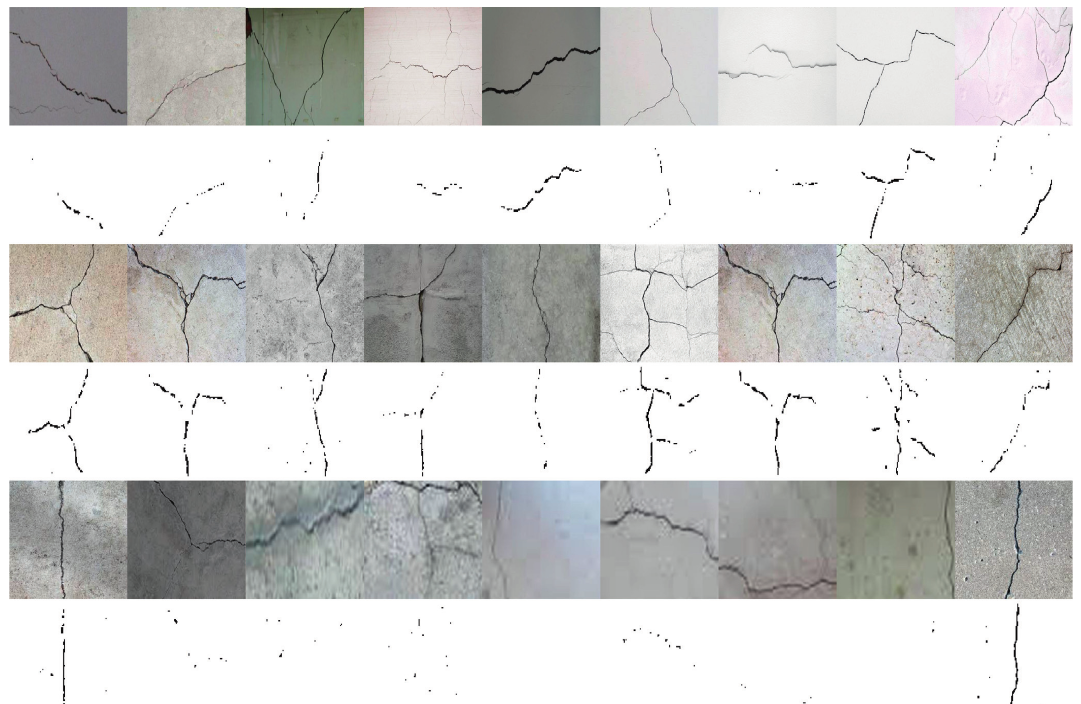
Figure 36: Percolation results using the enhanced percolation method with the cubic